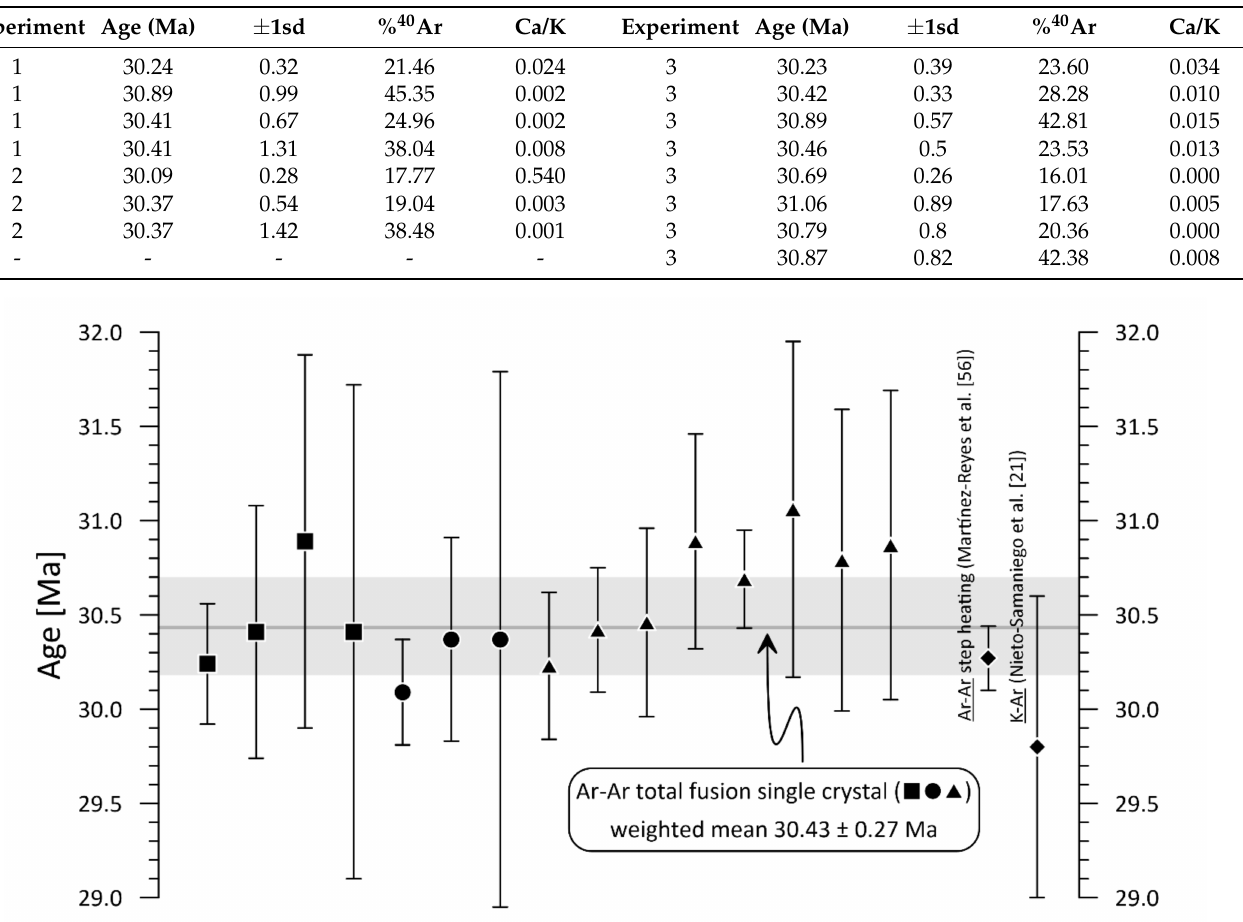
Figure 7. A plot of available Ar–Ar and K–Ar ages from valencianite (La Valenciana, Guanajuato, Mexico. The symbols square, circle, and triangle correspond to experiments 1, 2, and 3 from Table 5. Error bars are one standard